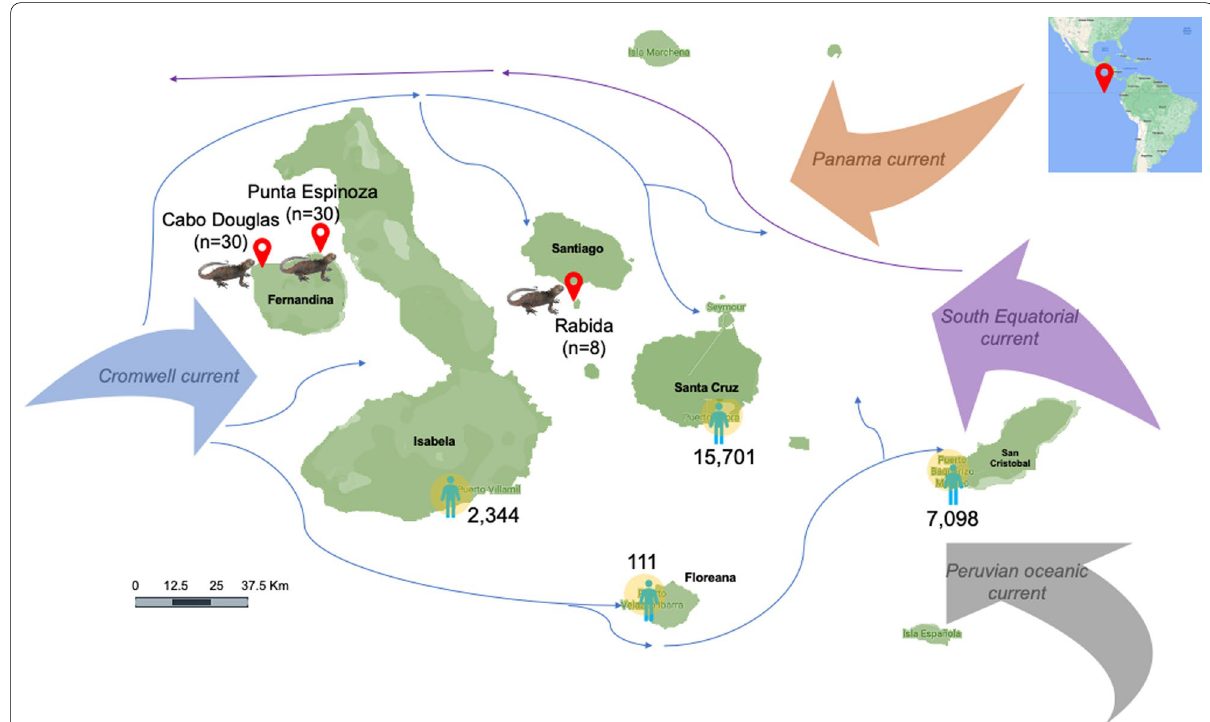
Fig. 1 Geographic location of the sampling sites in the Galapagos Islands. The main current systems and the human population of the archipelago are